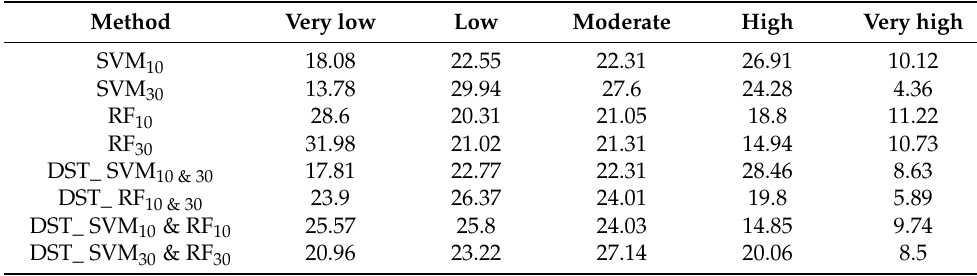
Table 5. The percentage of the area of each wildfire susceptibility class. Method Very low Low Moderate High Very